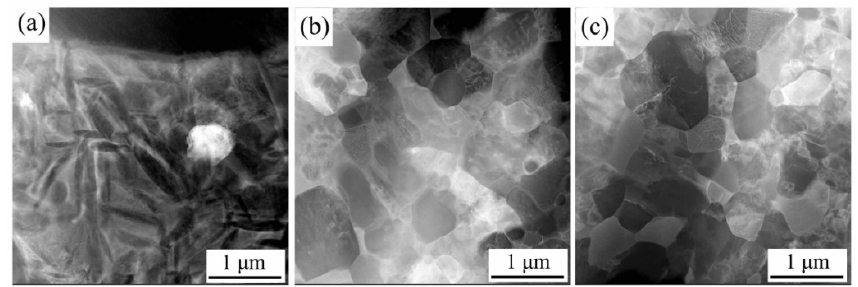
Figure 13. HADDF images of spun workpieces: ( a ) initial welded tube, ( b ) pass 3, ( c ) pass 6.